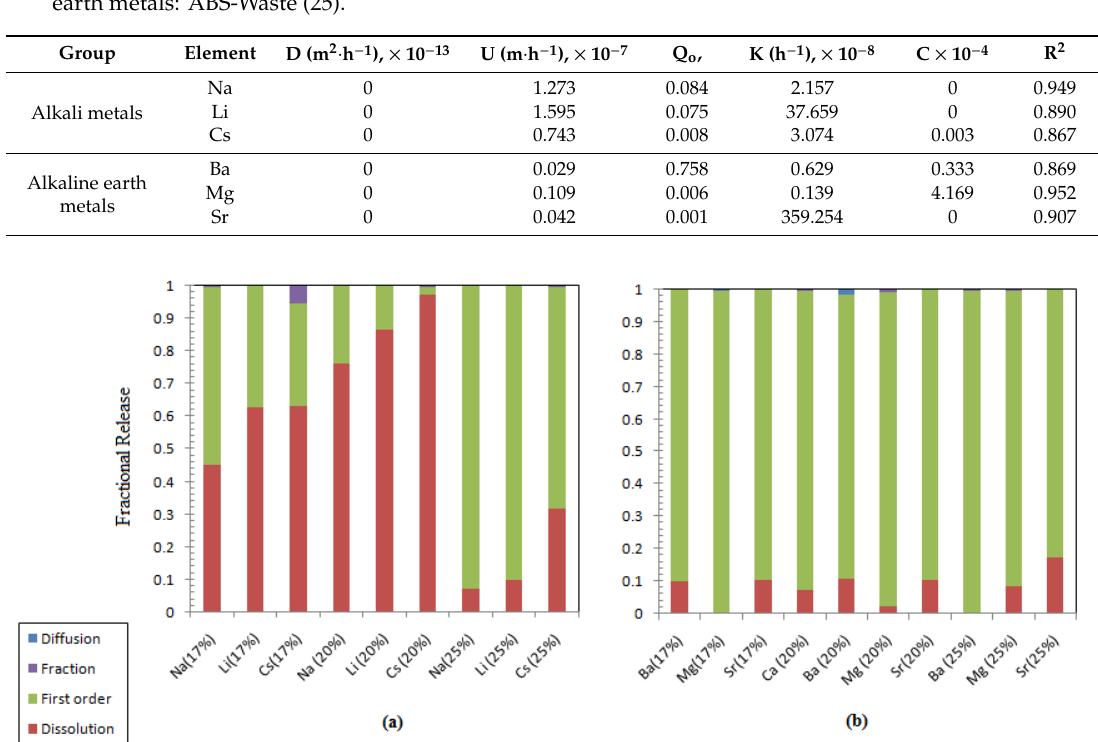
Table 13. Nonlinear curve fitting parameters of the cumulative leach fraction of alkali and alkaline earth metals: MABS-Waste (20).